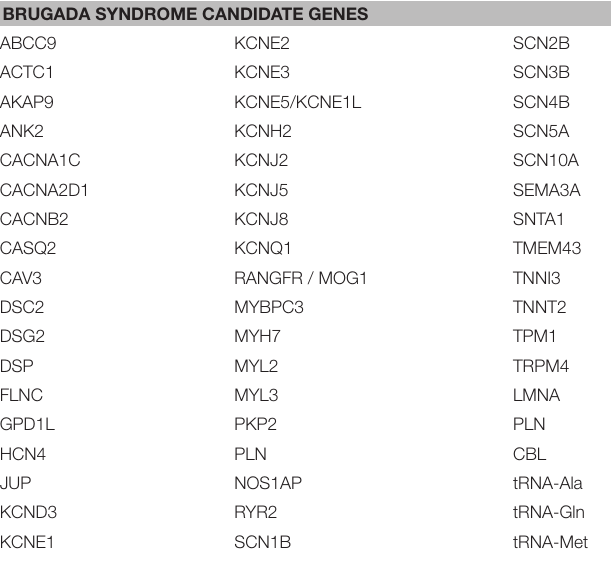
TABLE 1 | BrS candidate